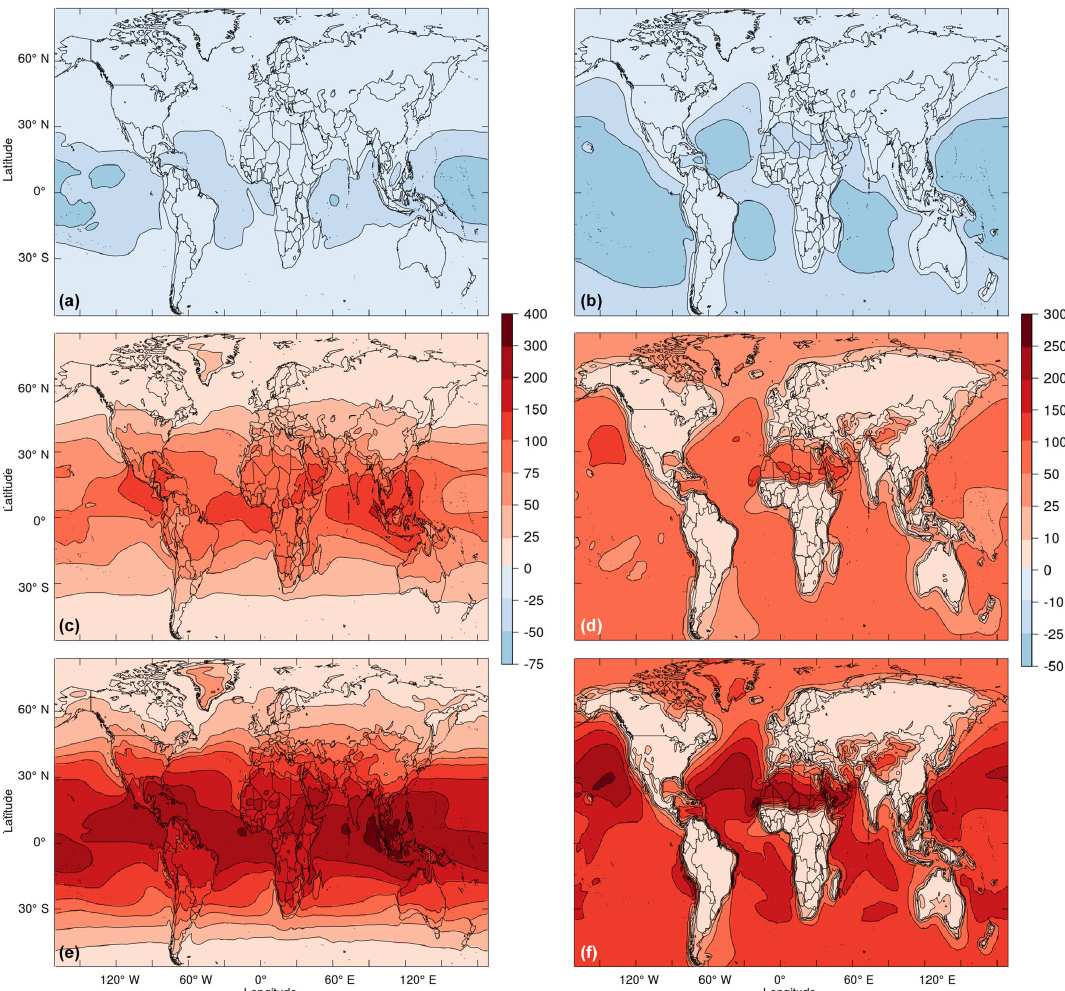
Figure 13. Annual mean changes in methanol abundances from run 1 ( γ = 0, a, b ), run 2 ( γ = 0 . 2, c, d ), and run 3 ( γ = 0 . 4, e, f ), relative to the base run. Changes are shown in absolute (in pptv, a, c, e ) and relative terms (percentage change, b, d, f